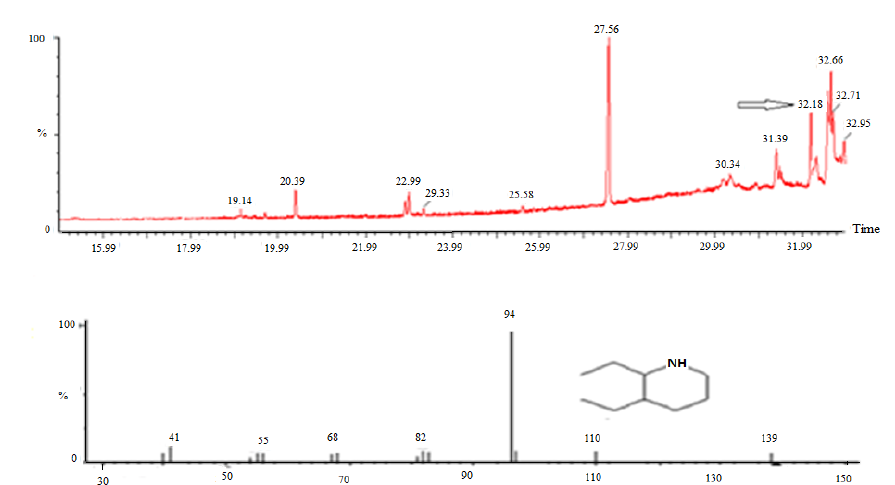
Figure 8. GC–MS of compound 4.